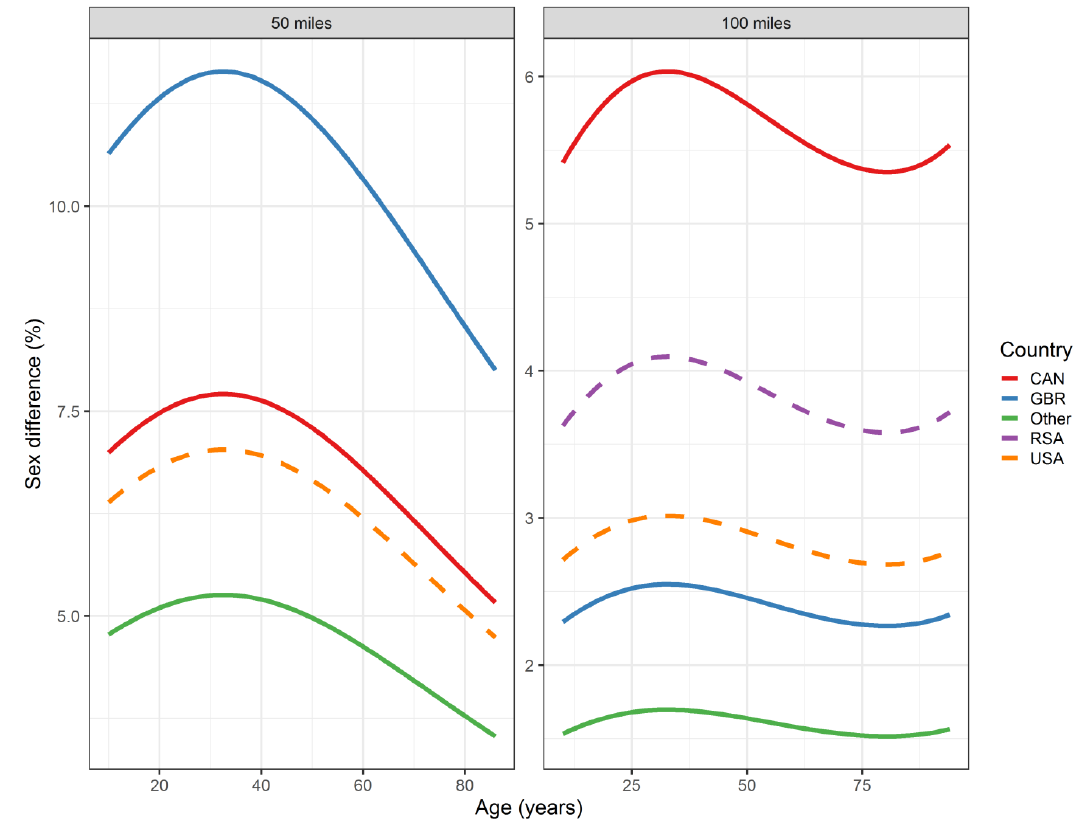
Figure 5. Sex di ff erences by age (in years) and country in 50- and 100-mile ultra-marathons. Curves represent fitted values. For 50-mile races, South Africa was combined with other countries. USA = United States of America, CAN = Canada, GBR = Great Britain, RSA = Republic of South Africa, W = women, M = men. Sex di ff erences (%) in performance were defined as 100 × (women’s race time–men’s race time) / (men’s race time).